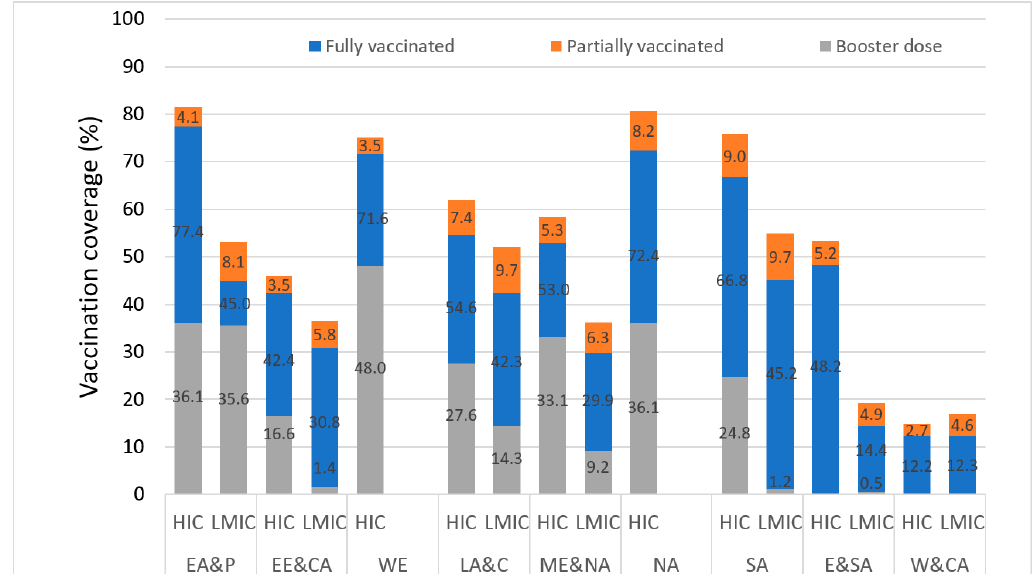
Figure 3. Vaccination coverage by UNICEF regions and income group as of 15 February, 2022. HIC: High Income Country; LMIC: Low- and Middle- Income Country; EA&P: East Asia and Pacific; EE&CA: Eastern Europe and Central Asia; WE: Western Europe; LA&C: Latin America and Caribbean; ME&NA: Middle East and North Africa; NA: North America; SA: South Asia; E&SA: Eastern and South Africa; W&CA: Western and Central Africa.